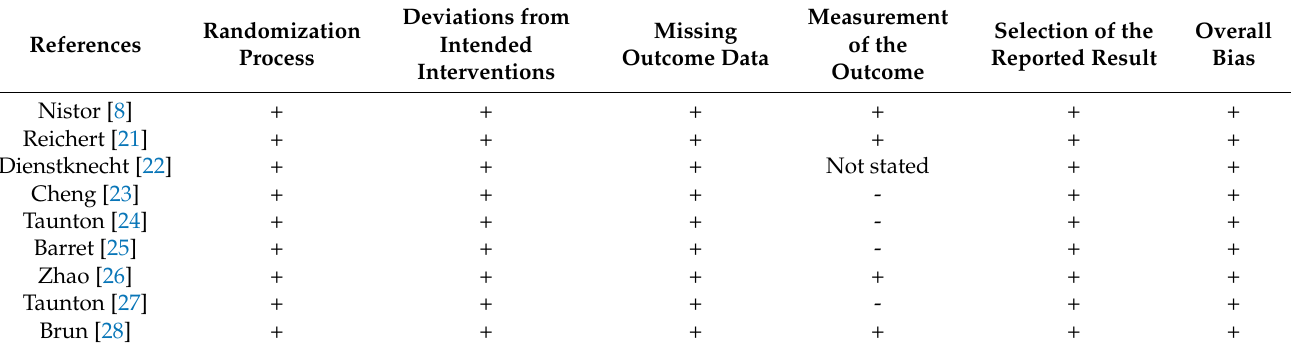
Table 3. Cochrane Collaboration’s tool risk of bias